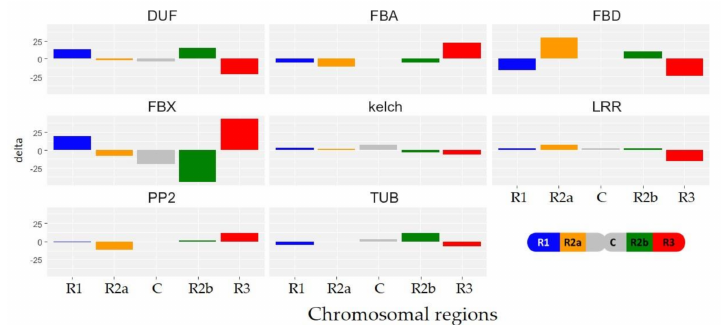
Figure 4. Excess and deficit of the eight major TaFBX gene subfamilies among the five chromosomal regions. The excess or deficit was calculated as a subtraction of the observed TaFBX number Figure 1. orange for R2a, grey for C, green for R2b and red for R3).